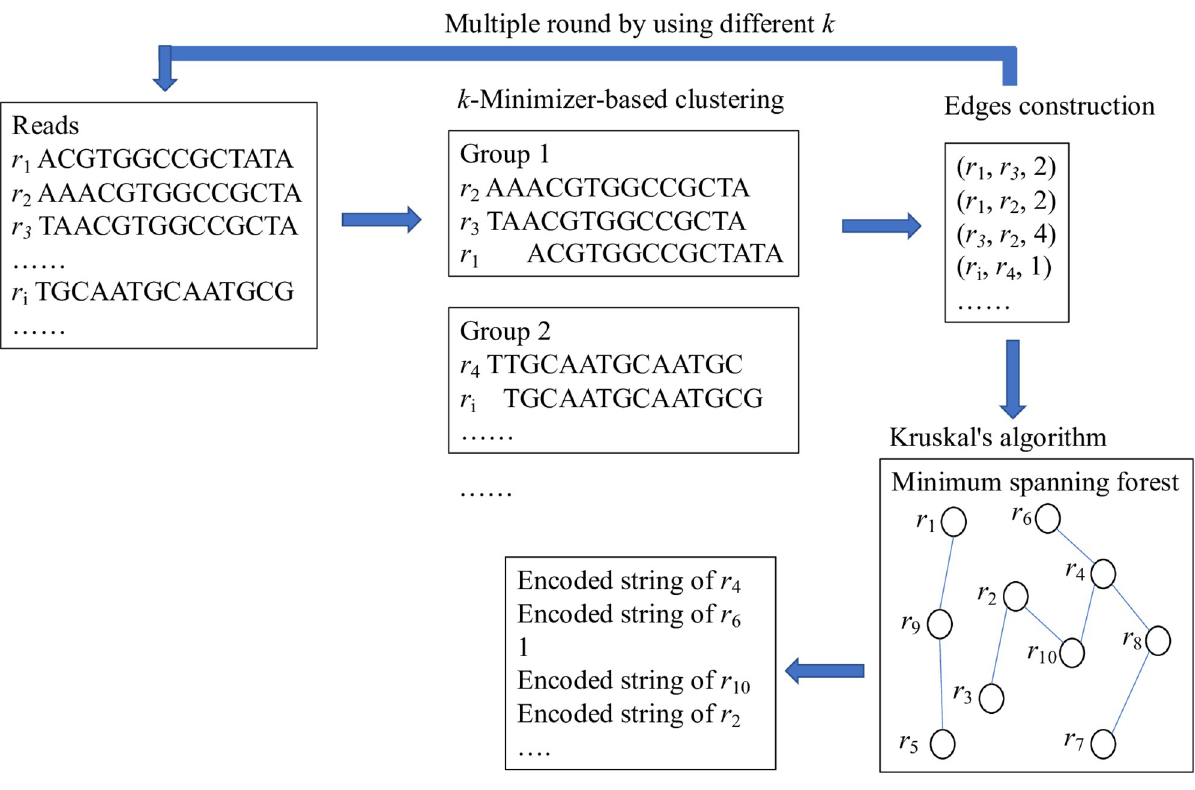
Fig 2. The framework of